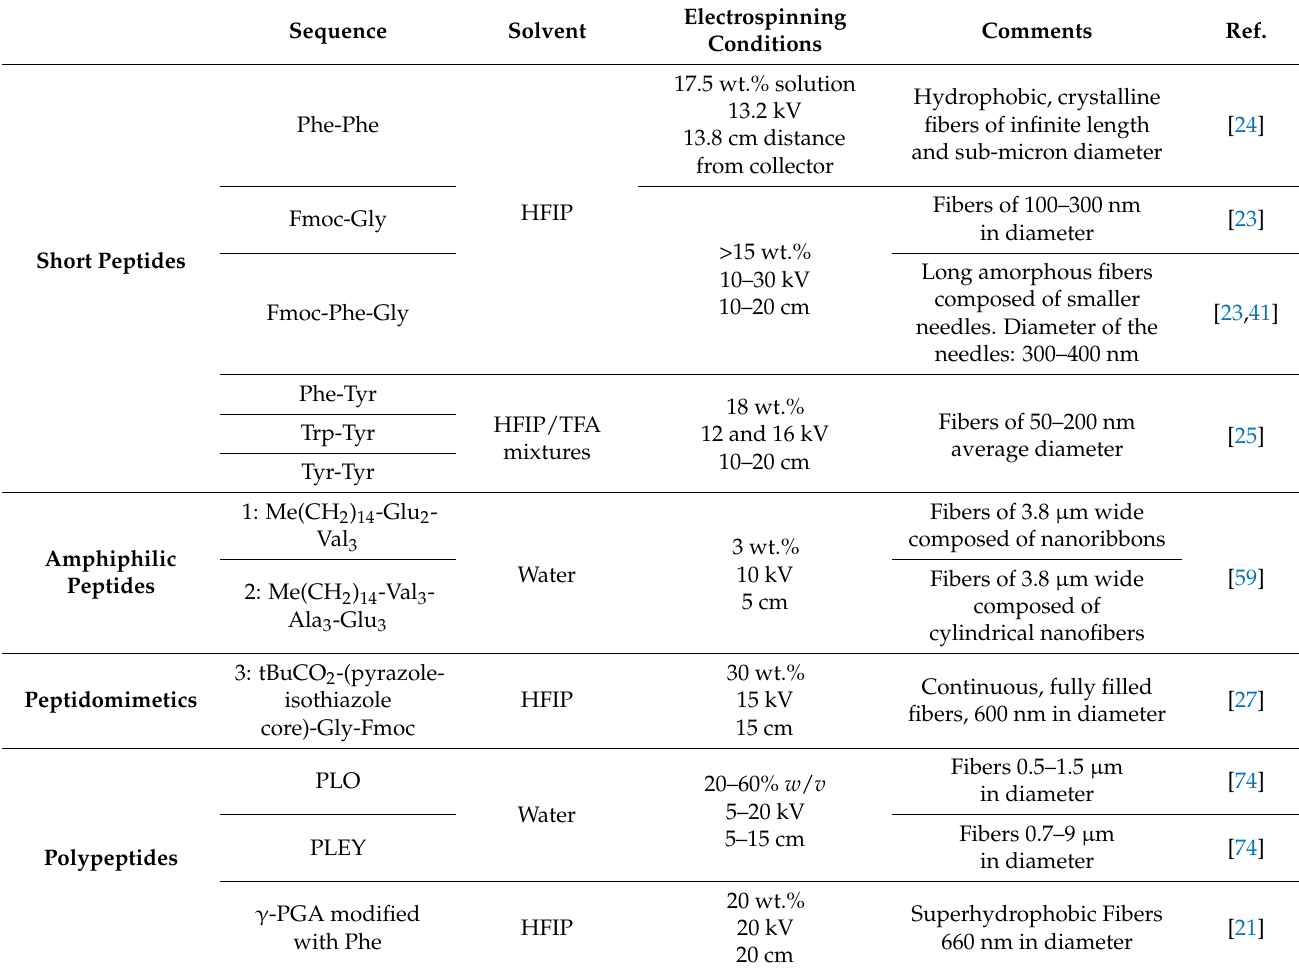
Table 3. Characteristics of electrospun fibers